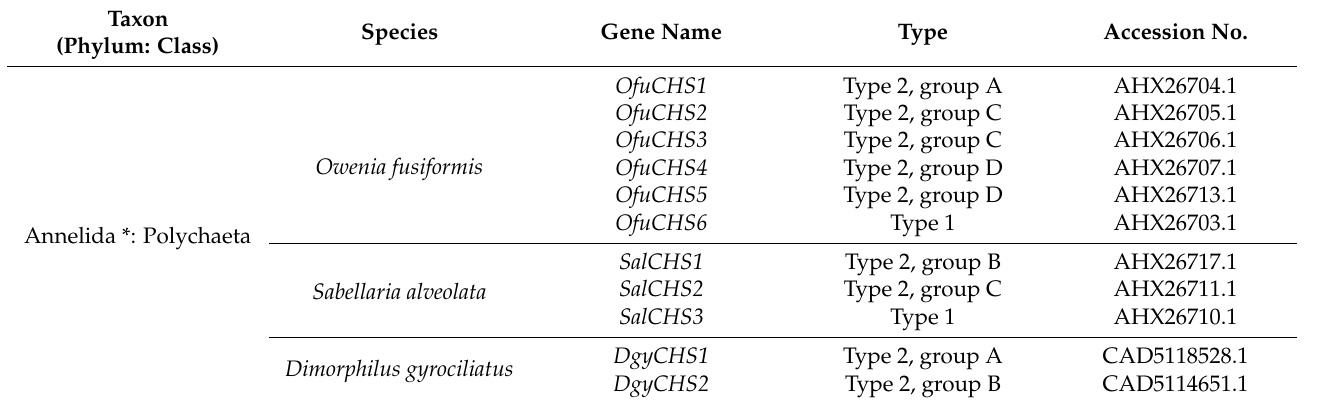
Table 1. Gene list of chitin synthases used for phylogenetic